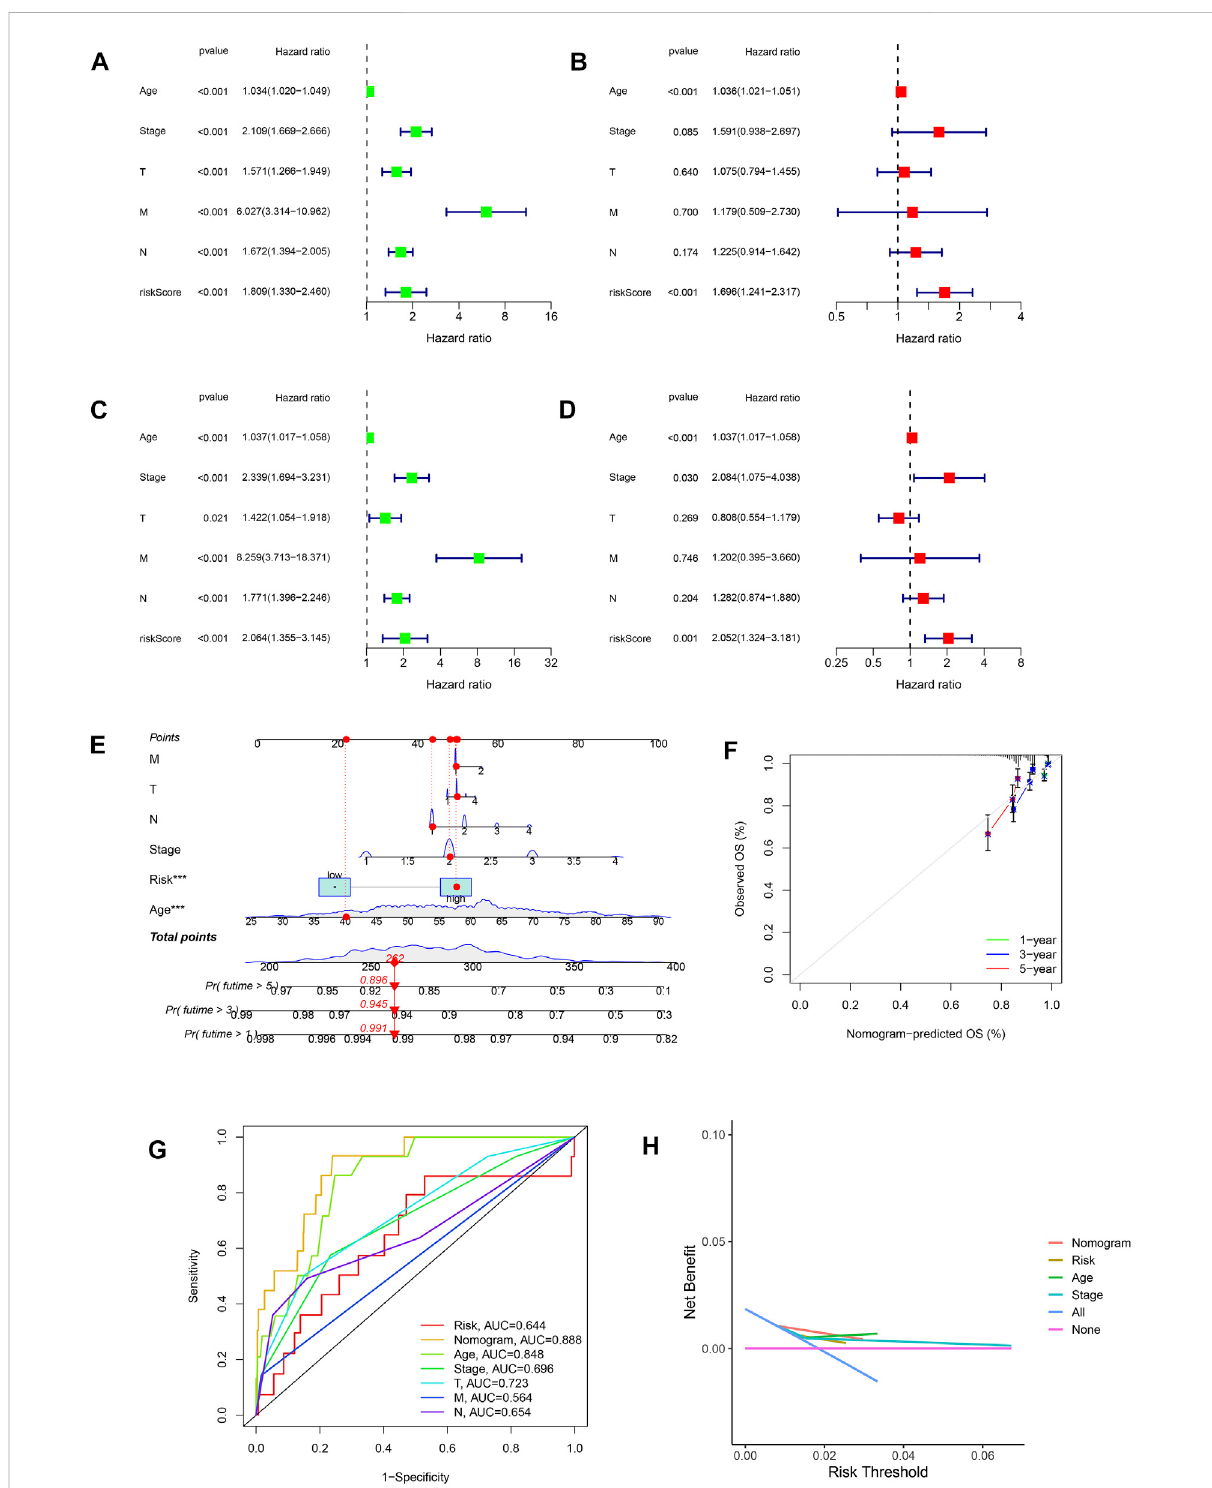
FIGURE 5 Relationship between risk scores and clinical features. (A,B) Univariate and multivariate Cox analyses considering risk score, age, tumor stage, and TNM stage in the training cohort. (C,D) Univariate and multivariate Cox analyses considering risk score, age, tumor stage, and TNM stage in the test cohort. (E) Nomogram combining risk score and clinicopathological factors. (F) Calibration plots established to compare the proposed nomogram with an ideal model. (G) AUCs showing that this nomogram had higher accuracy in OS than other factors. (H) Net bene fi t of the proposed nomogram, risk group, age, and tumor